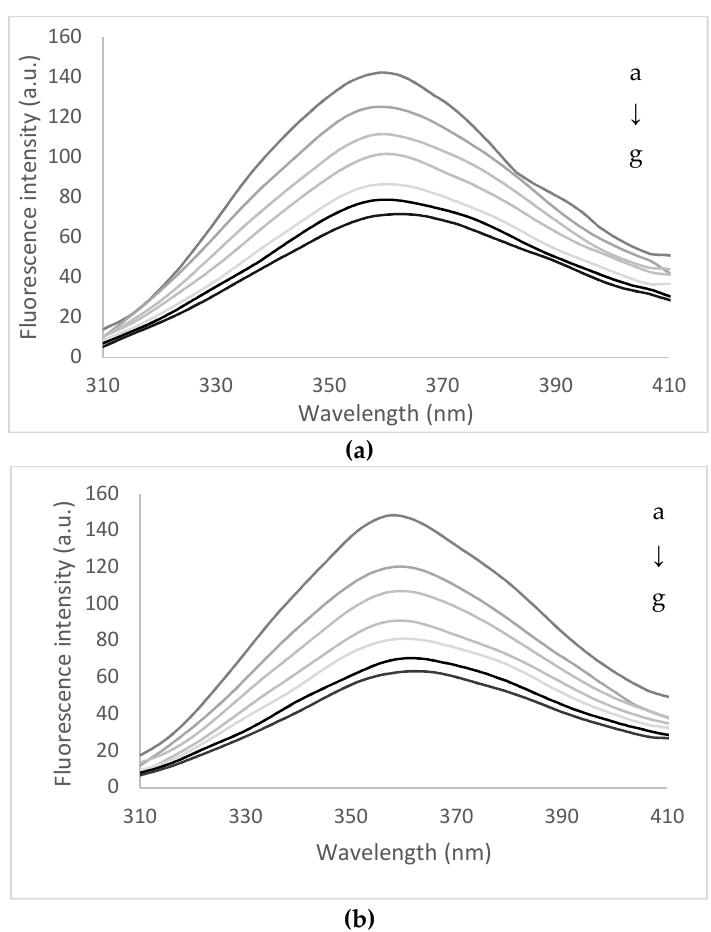
Figure 2. The fluorescence spectra of the interaction between fish waste low molecular peptides thermally treated at 25 °C ( a ) and 95 °C ( b ) and flavonoids from yellow onion skins. The flavonoids concentration (from a–g) varied from 0 to 1.40 × 10 −4 M.